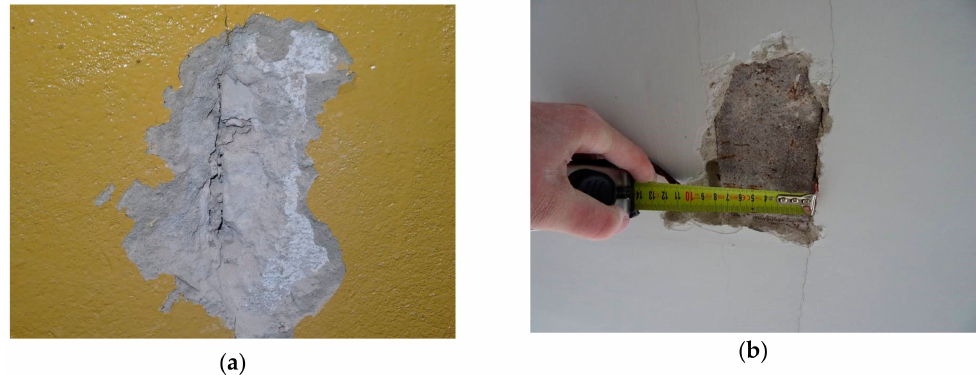
Figure 5. Uncovered main structure elements: ( a ) vertical crack of the brick wall; ( b ) measurement of uncovered steel